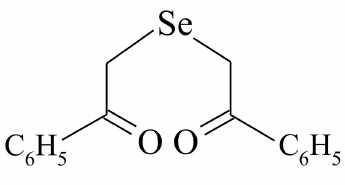
Figure 5. Structure of the compound